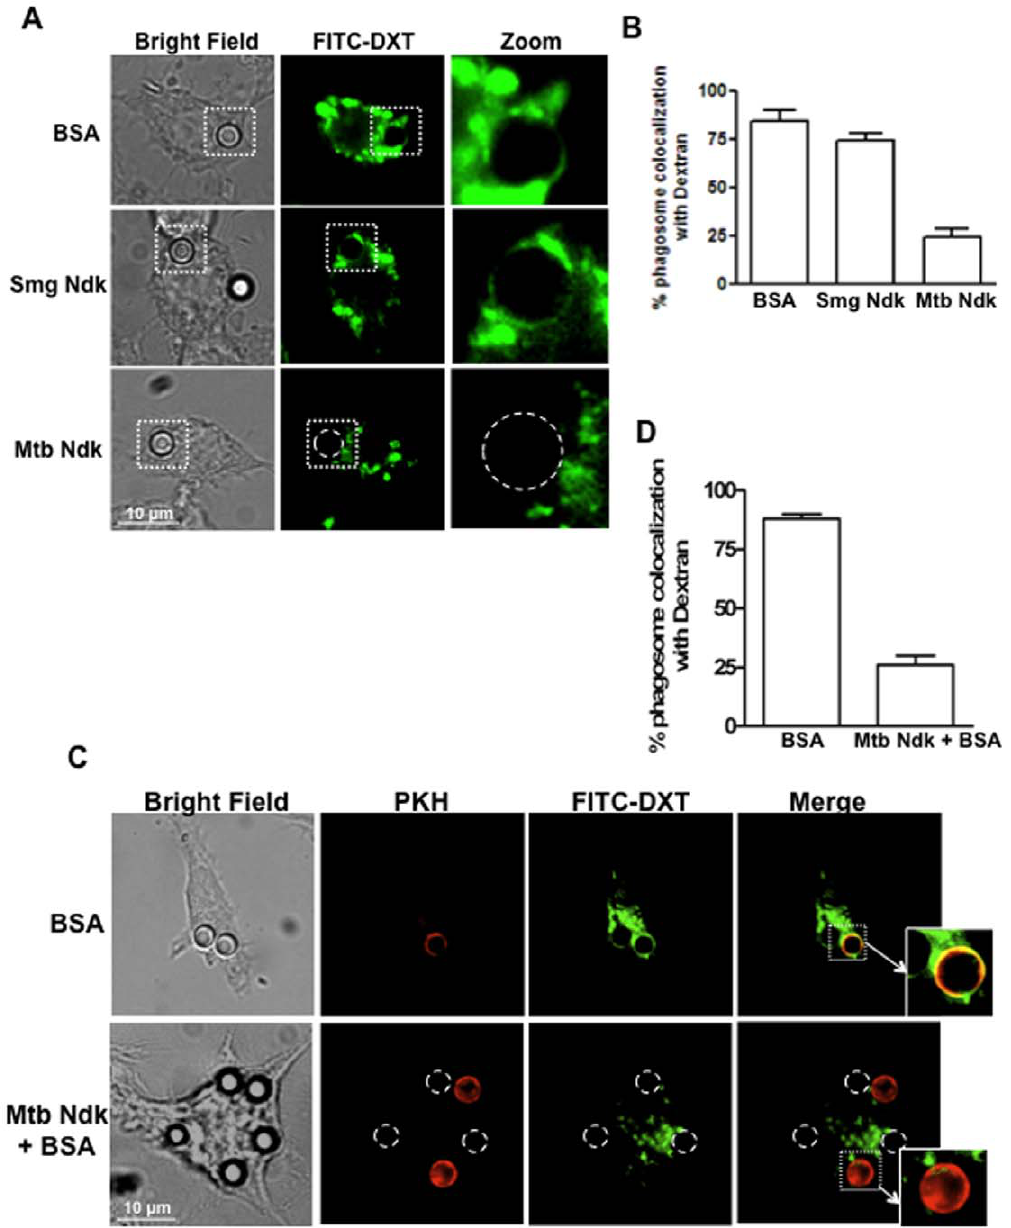
Figure 2. Ndk contributes to phagosome maturation arrest. A. RAW 264.7 cells were pulse-chased overnight with FITC-DXT (0.5 mg/ml) and allowed to ingest control BSA-coated, Mtb Ndk-coated, or M. smegmatis Ndk-coated latex beads. Two hours post-phagocytosis, cells were washed and fixed for analysis by confocal microscopy. B. Quantification of the confocal data shown in panel A. C. RAW 264.7 cells were loaded with FITC-DXT overnight and allowed to ingest a mixture (1:1) of either PKH-labelled BSA-beads and unlabelled BSA-beads (upper panel, control) or PKH-labelled BSA-beads and unlabelled Ndk-beads (lower panel). Two hours post-phagocytosis, cells were trypsinized, washed, and fixed for analysis by confocal microscopy. The top panel (BSA control), the yellow signal reflects a colocalization of the PKH-BSA-beads with the lysosomal marker dextran. In the bottom panel dotted circles indicate the position of Ndk-beads, while the red fluorescent signal (PKH) shows the location of BSA-beads and a significant decrease of dextran colocalization with distant PKH-BSA-beads. D. Quantification of the confocal data shown in panel C. Values in B and D are the mean 6 SD of phagosome colocalization of with FITC-DXT in 50–80 cells from three independent experiments. doi:10.1371/journal.pone.0008769.g002 on distant vacuoles containing red-fluorescent BSA-beads. Indeed, surrounded PKH-phagosomes in cells co-infected with control confocal images of cell co-infected with Ndk-beads and PKH- beads coated with BSA ( Fig. 2C , upper panel) indicative of fusion beads, ( Fig. 2C , lower panel) and their quantification ( Fig. 2D ) with DXT-loaded lysosomes. The observation of Ndk-mediated showed that PKH-beads almost completely excluded FITC-DXT down-modulation of phagosome maturation cannot be attributed vesicles from their phagosomes as result of block of fusion with to a global toxicity of the host cell maturation. Indeed, the lysosomes. In contrast, an abundant green fluorescent signal viability, morphology and adherence of RAW infected with